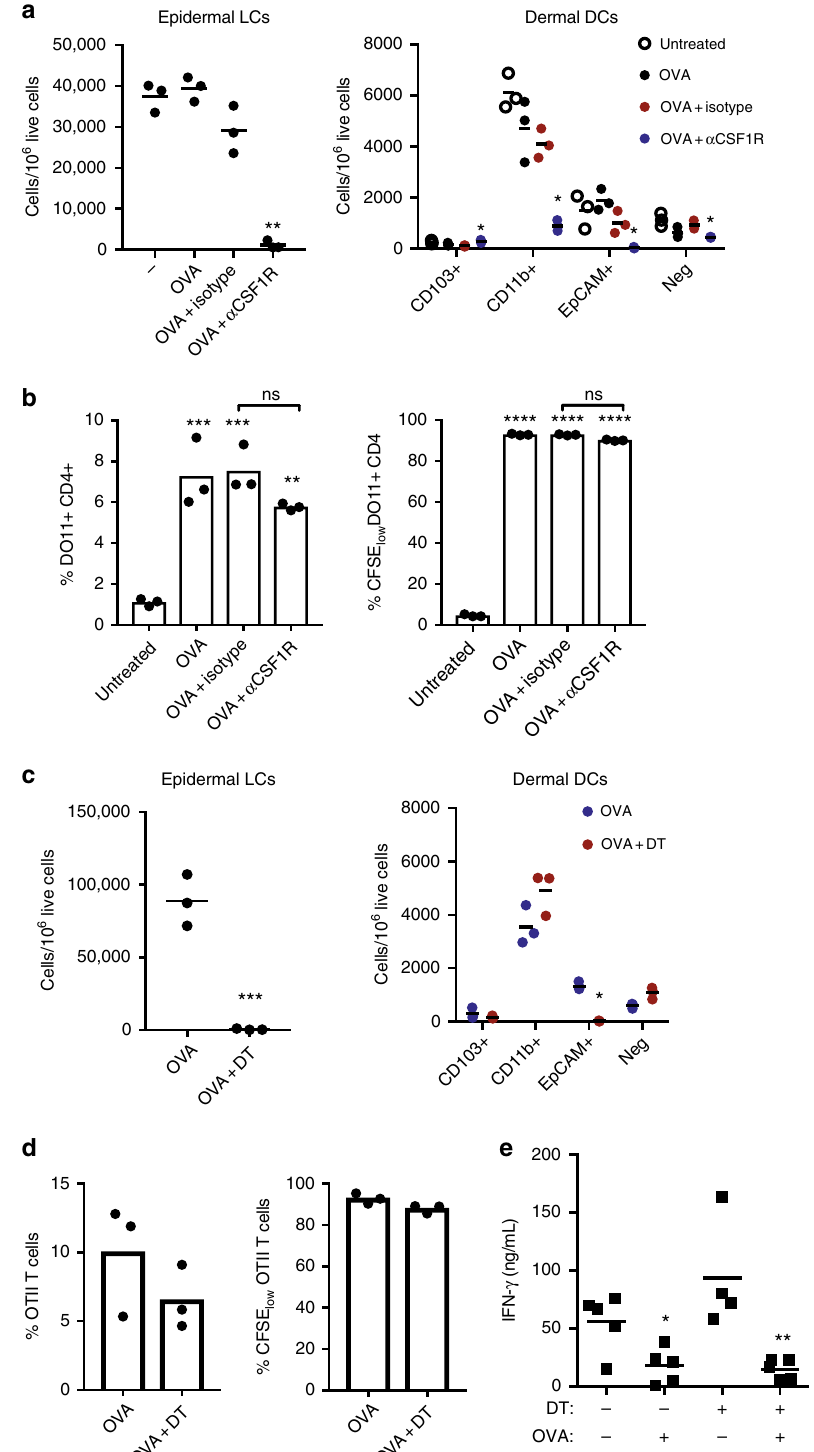
Fig. 4 Impact of Langerhans cell depletion on antigen presentation. a Number of cells per 10 6 live cells of the different CD11c + MCHII + subsets present in epidermis and dermis in the different groups of Balb/c mice. * p < 0.05, ** p < 0.01 vs. isotype control, t test. b Percentage of total or CFSE low (proliferated) DO11.10 CD4 + T recovered from brachial lymph nodes 7 days after application of OVA. ** p < 0.01, *** p < 0.001, **** p < 0.0001 vs. untreated. ANOVA